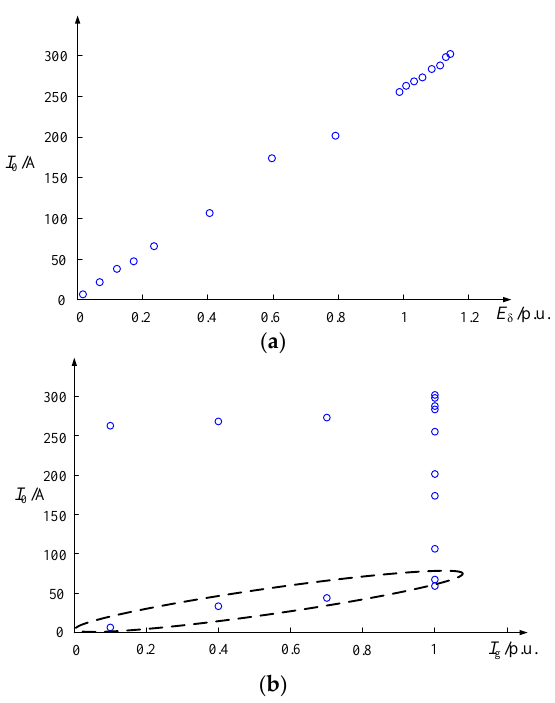
Figure 6. Simulation results of the generator transverse differential unbalanced current: ( a ) the relation diagram of the transverse differential unbalanced current with the air gap electromotive force; ( b ) the relation diagram of the transverse differential unbalanced current with the phase current. Table 1. Statistical results of the generator internal fault set and the protection action condition results. Internal Fault